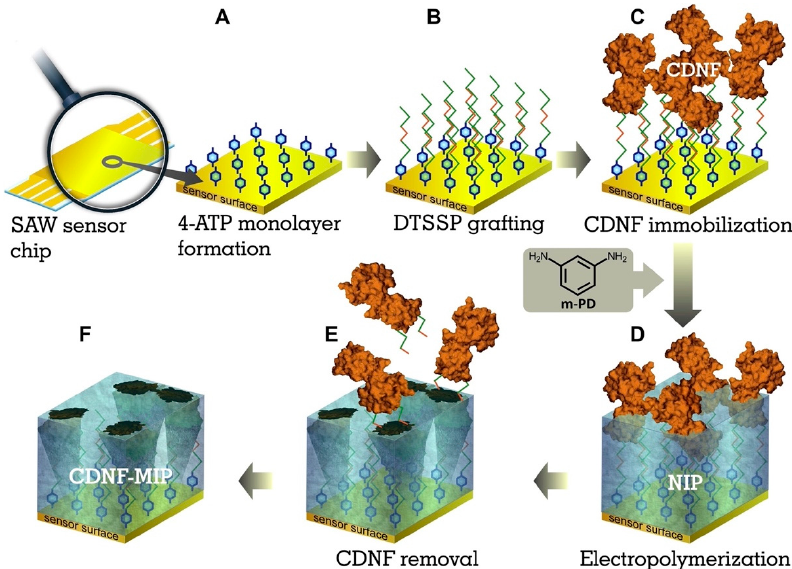
Figure 8. The surface-imprinting technique for synthesis of the CDNF-MIP film on SAW chip’s sur- face using the electropolymerization method; ( A ) The gold surface of SAW sensor chip and 4-ATP monolayer formation; ( B ) 3,3 ′ -dithiobis [sulfosuccinimidylpropionate] (DTSSP) linker grafting; ( C ) immobilization of the target protein CDNF; ( D ) electropolymerization of poly-mPD; ( E ) removal of target protein CDNF; ( F ) CDNF-MIP layer. Reprinted from [82] with permission from Kidakowa et al.